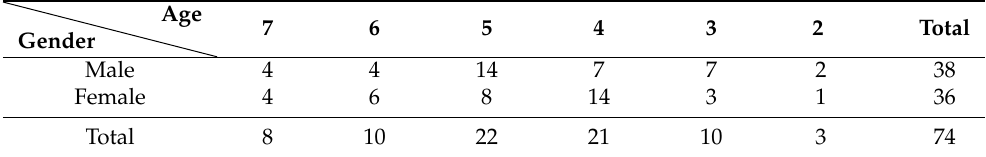
Table 3. Number of child face learning data collected.